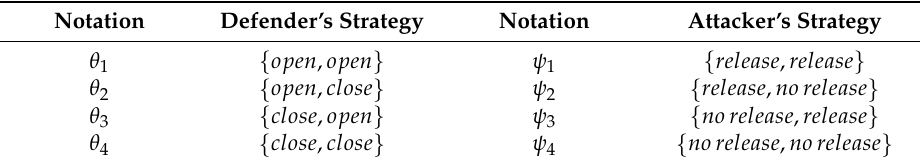
Table 1. Pure strategy of defender and attacker in one day with two time